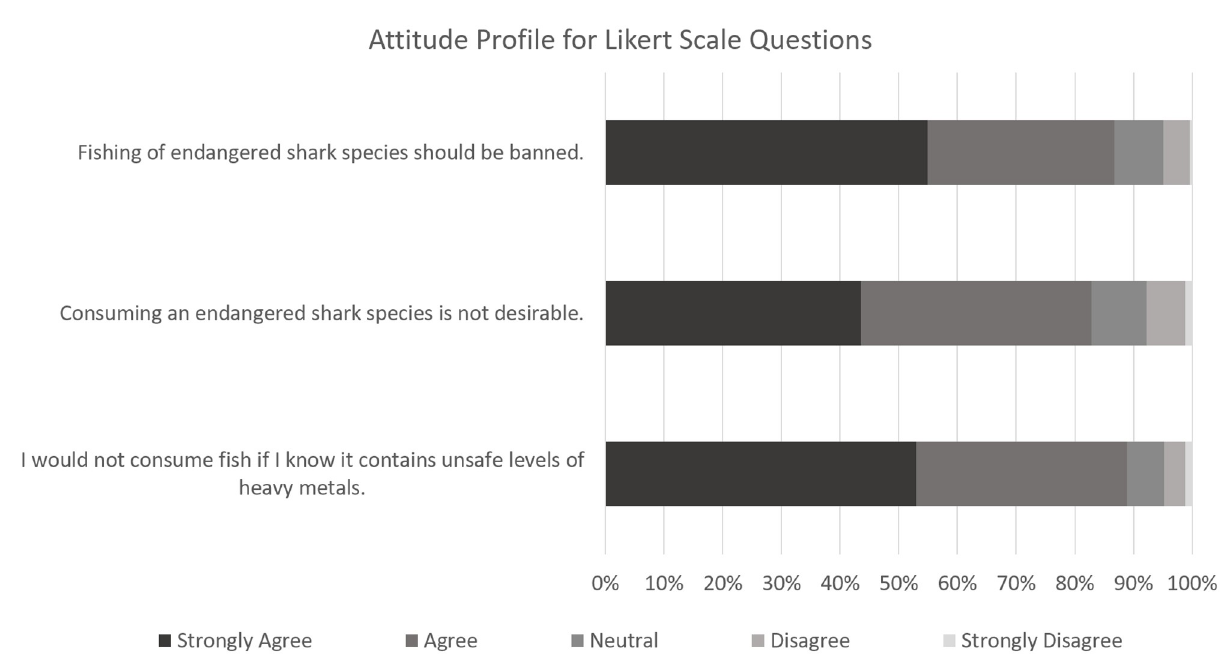
Fig 5. Attitude profiles in response to Likert scale questions. (See S2 Appendix).